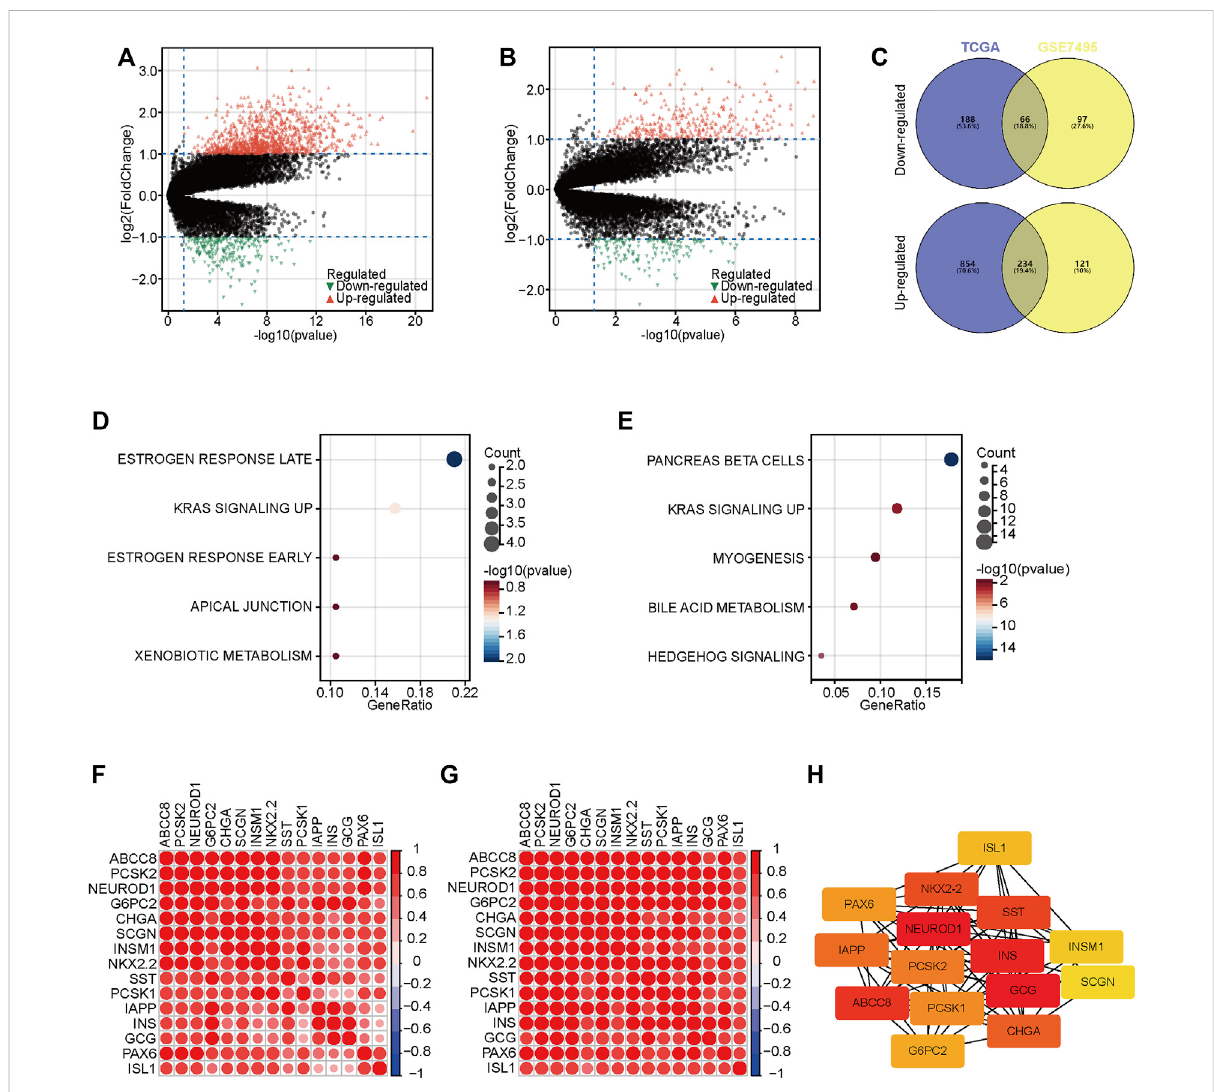
FIGURE 3 DEGs between low- and high-risk groups. (A,B) The volcano plot of DEGs with the thresholds of |log2[fold change (FC)]| > 1 and p < 0.05 in the TCGA and GSE57495 datasets. © Intersection of co-DEGs between the TCGA and GSE57495 datasets. (D,E) Hallmark enrichment analysis of highly expressed genes in the high-risk and the low-risk groups. (F,G) Correlation analysis of 15 genes in the “ pancreas beta cells ” terms. (H) PPI network analysis of 15 genes in the “ pancreas beta cells ”